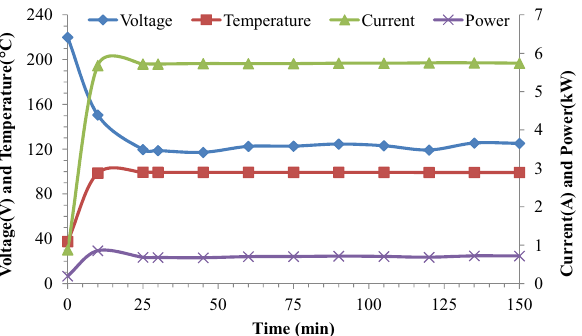
Figure 3. Variation in average electrical parameters and temperature during ohmic heating of lemongrass